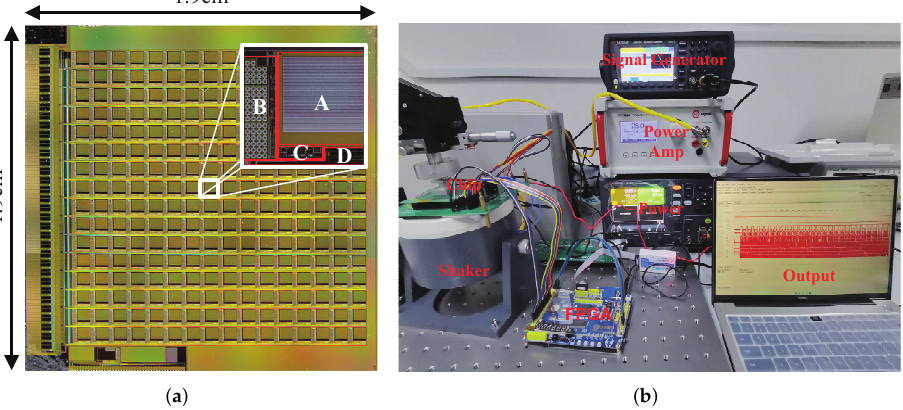
Figure 11. ( a ) The chip microphotograph. A: Tactile sensor. B: AFE. C: ∆Σ modulator. D: Digital decimation filter. ( b ) Demonstration of readout circuit